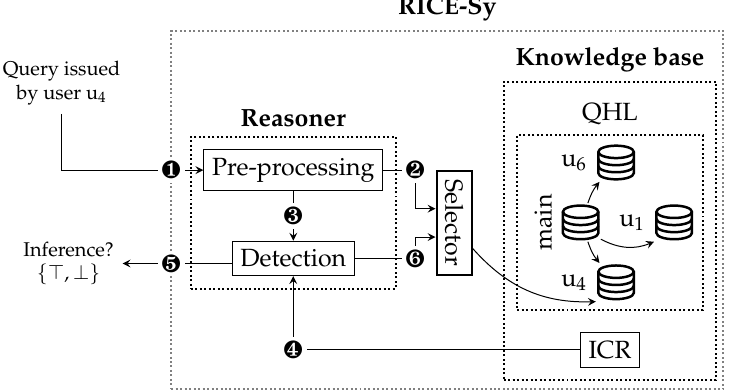
Figure 8. User-oriented partitioning of the QHL when a query issued by u 4 is processed by